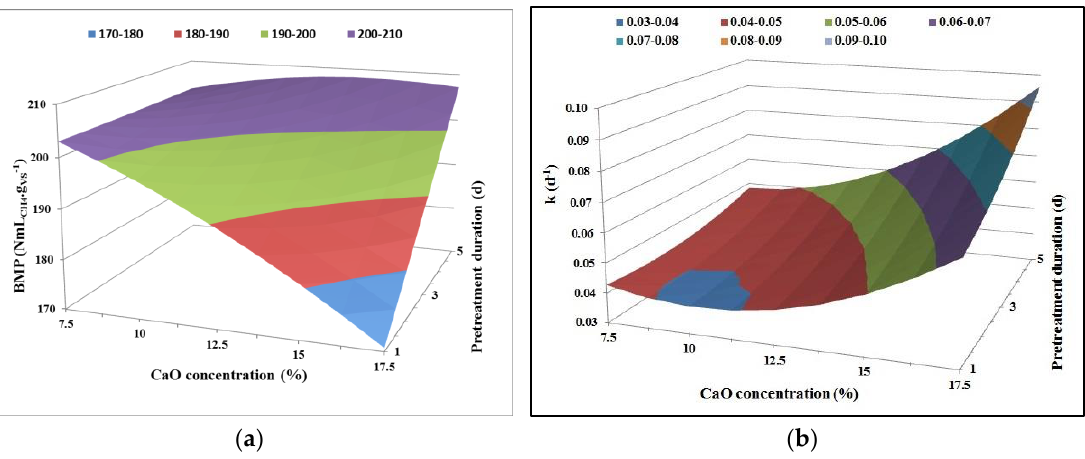
Figure 2. Response surface plots showing the impact of lime concentration and pretreatment duration on BMP ( a ) and kinetics values ( b ) for Design 1.